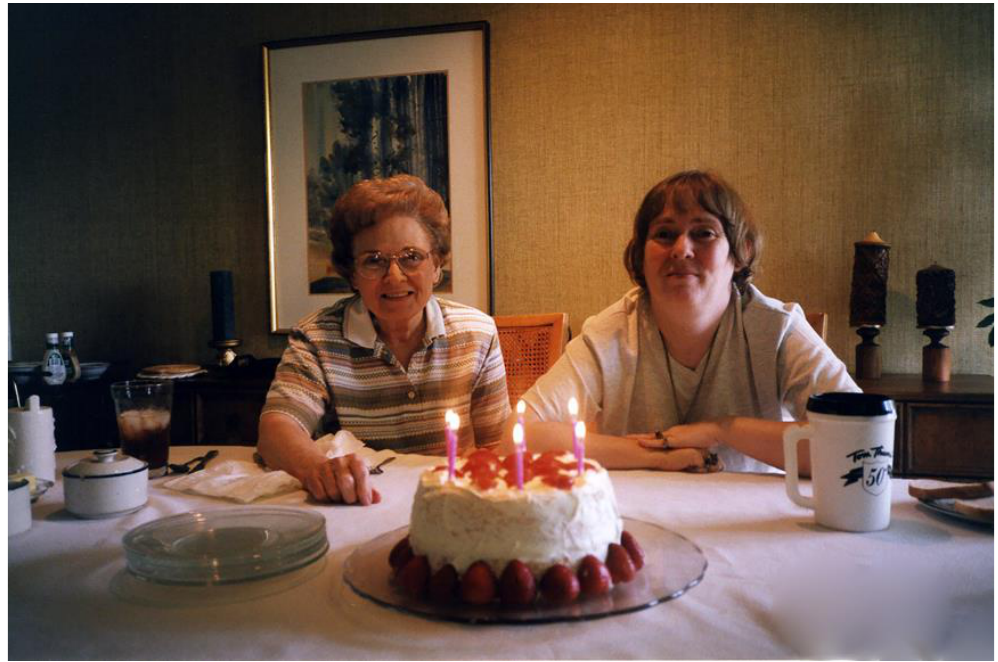
Figure 3: Mimi and Dona at a birthday celebration. Courtesy: Sophie Anthropology & Aging